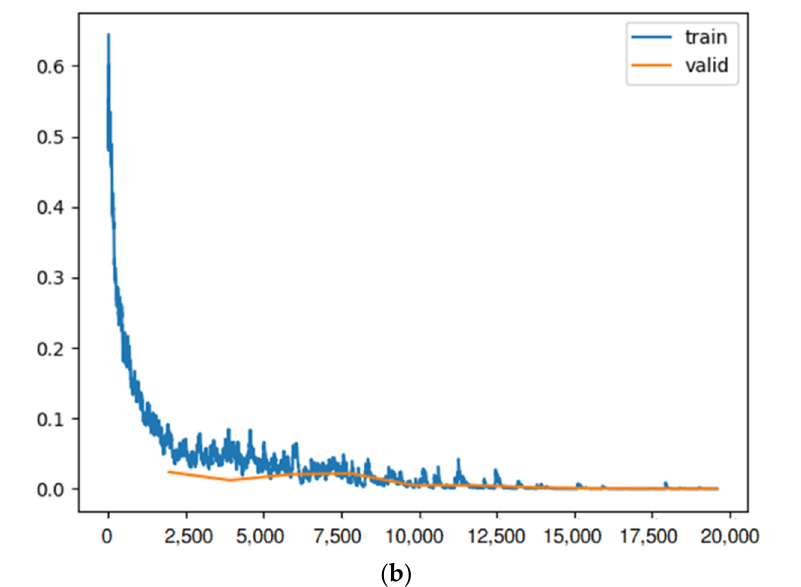
Figure 15. ( a ) Confusion matrix and ( b ) loss rate during training with VGG16_bn.